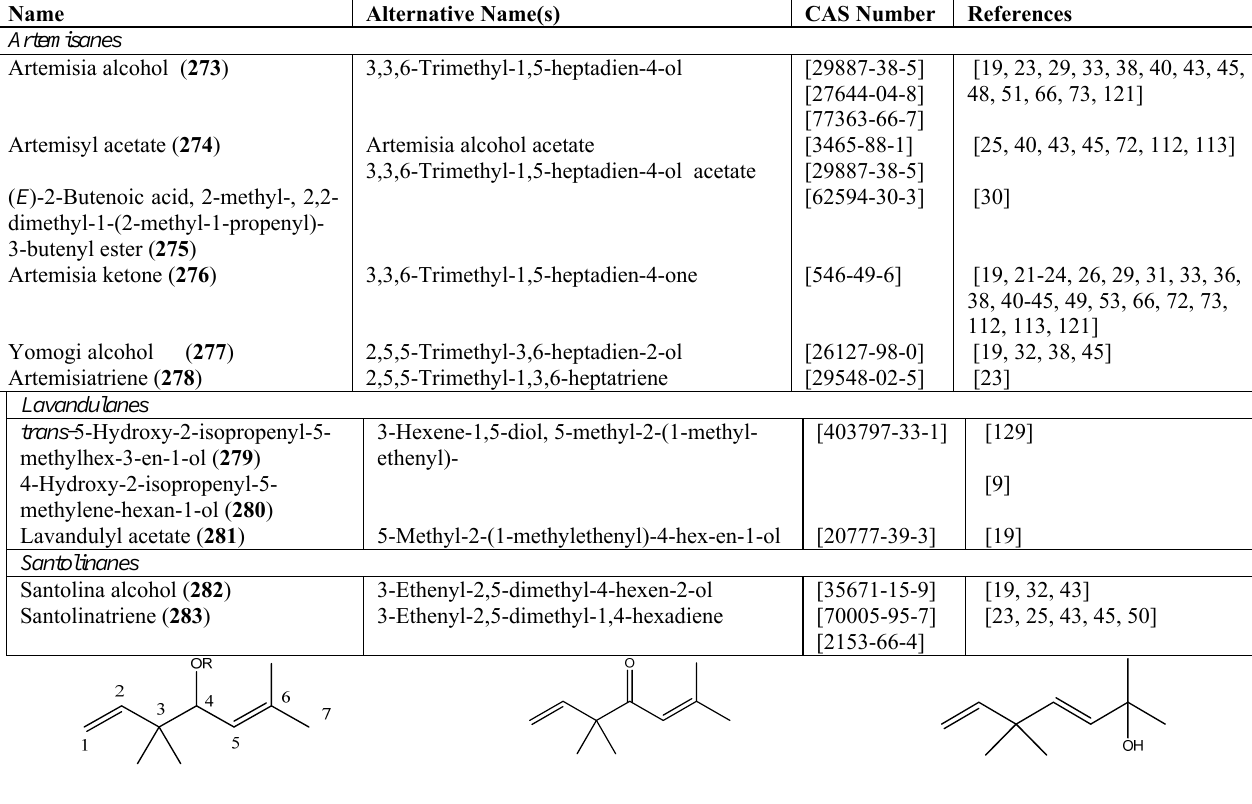
Table 24. Irregular Acyclic